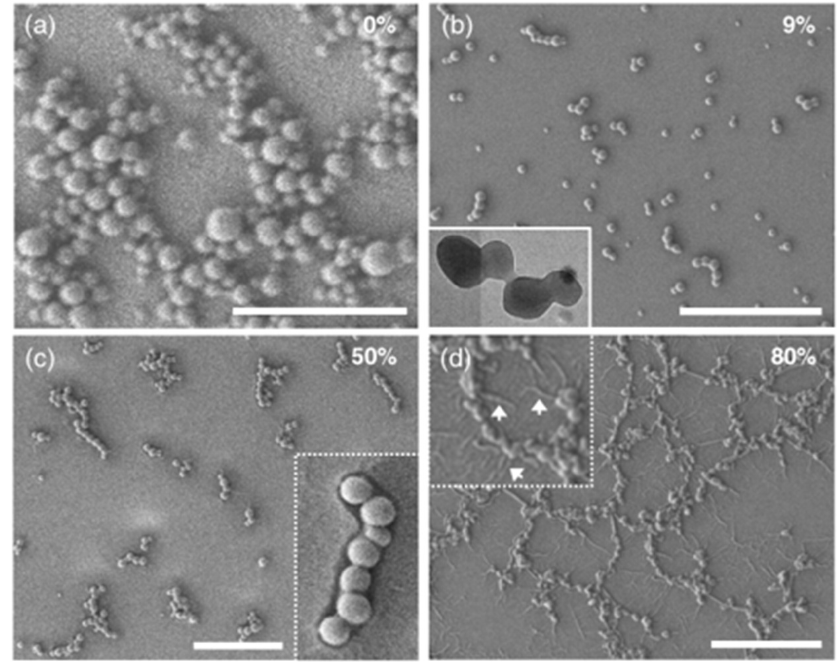
Figure 2. SEM and TEM images of diverse micro- and macrostructures formed at various mixing ratios ( v / v ) of mPEG1000:Bu (50 mg/L:50 mg/L) THF-H 2 O mixed solution. f mPEG1000 = ( a ) 0%, ( b ) 9%, ( c ) 50%, and ( d ) 80%. Scale bar: 5 µm.